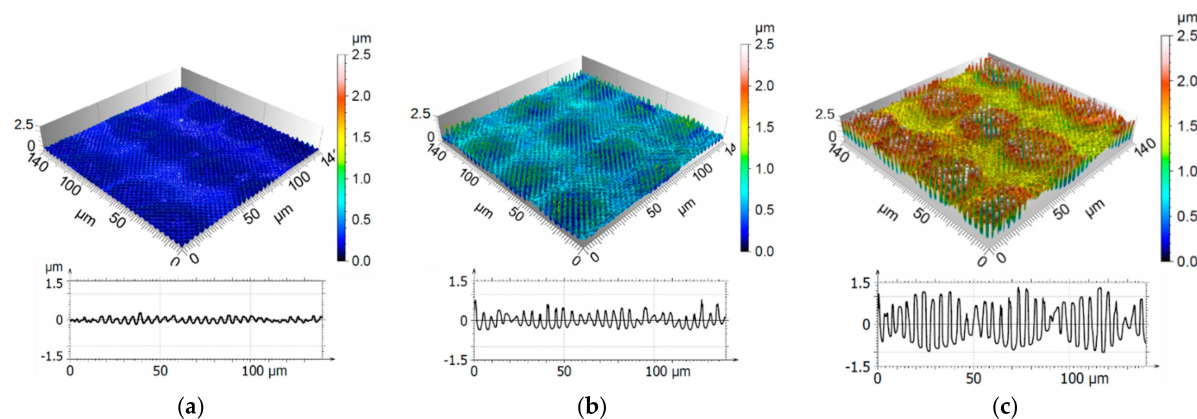
Figure 7. Confocal microscopy images of periodic microstructures and extracted profiles of DLIP structured stainless steel surfaces with ( a ) 1, ( b ) 5, and ( c ) 10 applied pulses. The measured average structure depth was ( a ) 0.23 µ m, ( b ) 0.74 µ m, and ( c ) 1.74 µ